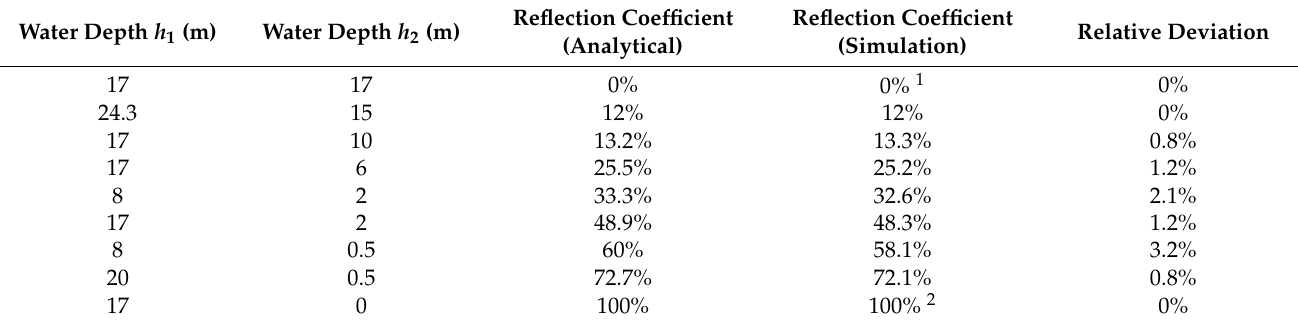
Table 2. Comparison of calculated and simulated reflection coefficients for different